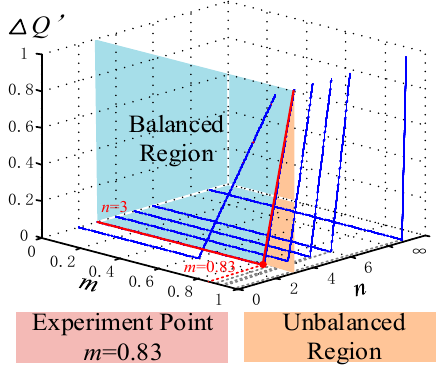
Figure 7. Voltage-balancing ability calculation.